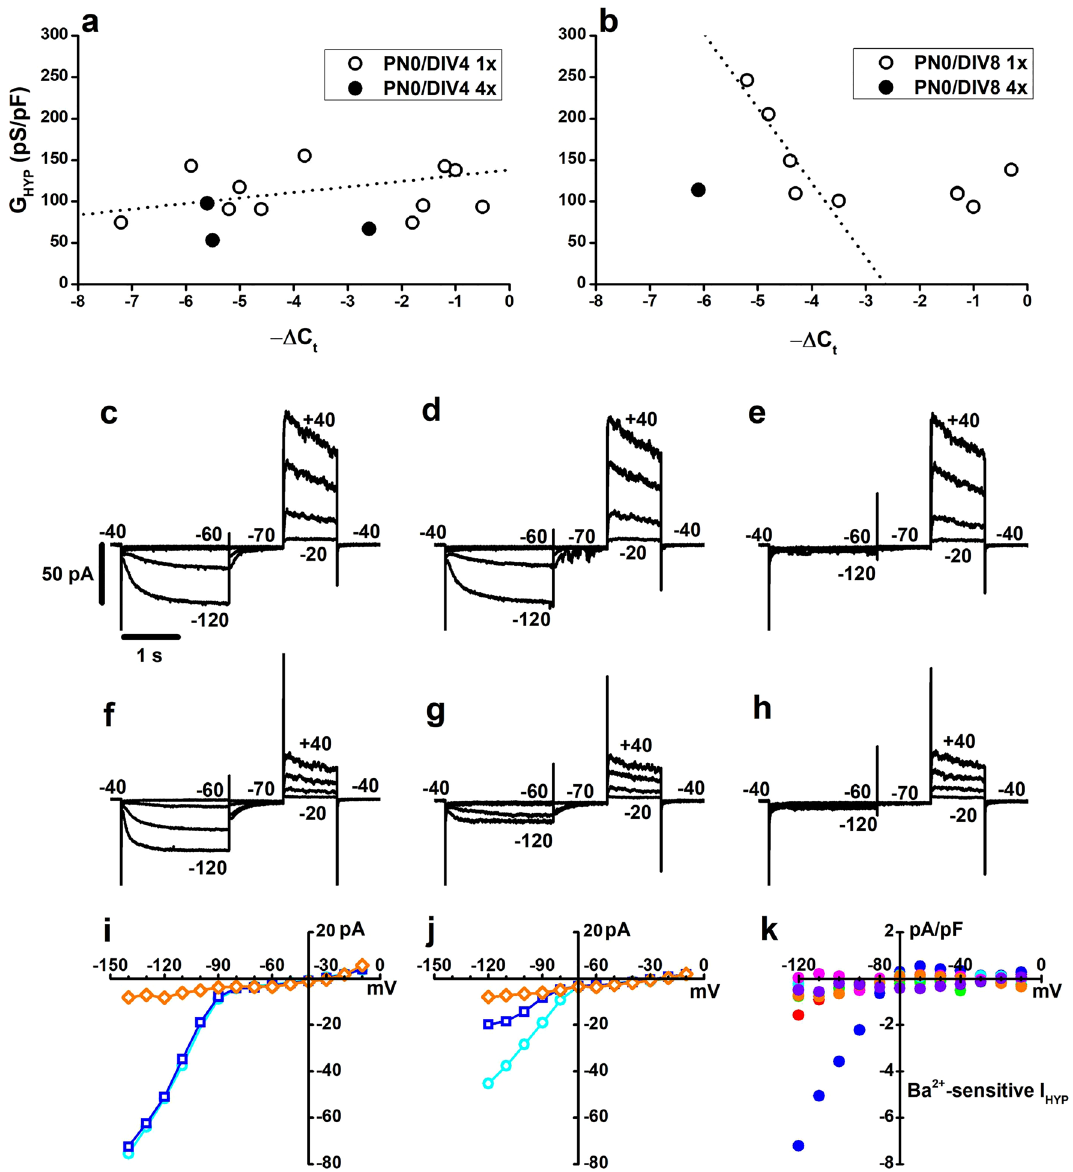
Figure 5. Correlation between gene expression and membrane conductance in single rod precursors. ( a , b ) Circles plot G HYP as a function of Hcn1 ΔC t for PN0/DIV4 ( a ) and PN0/DIV8 ( b ) GFP + cells. Dotted lines plot best-fitting straight lines to GFP + cultured at the lower density (open circles). ( c – h ) Sweeps plot currents activated by hyperpolarising and depolarising voltage steps in PN0/DIV8 GFP + cells, as indicated by numbers close to the sweeps, in saline with 30 mM KCl ( c , f ), in saline with 30 mM KCl + 2 mM BaCl 2 ( d , g ), and saline with 30 mM KCl, 2 mM BaCl 2 and 3 mM CsCl to block the residual I h . ( i , j ) I/V curves plot membrane currents measured at the end of the 2 s-long hyperpolarization steps in 30 mM KCl (cyan circles), 30 mM KCl + 2 mM BaCl 2 (blue squares), 30 mM KCl + 2 mM BaCl 2 + 3 mM CsCl (orange diamonds) for the cell in ( c – e ) ( i ) and in ( f – h ) ( j ). ( k ) Circles plot the amplitude of the BaCl 2 -sensitive current in 6 PN0/DIV8 GFP cells cultured at the 1 × cell density. Current amplitudes have been normalised by cell membrane